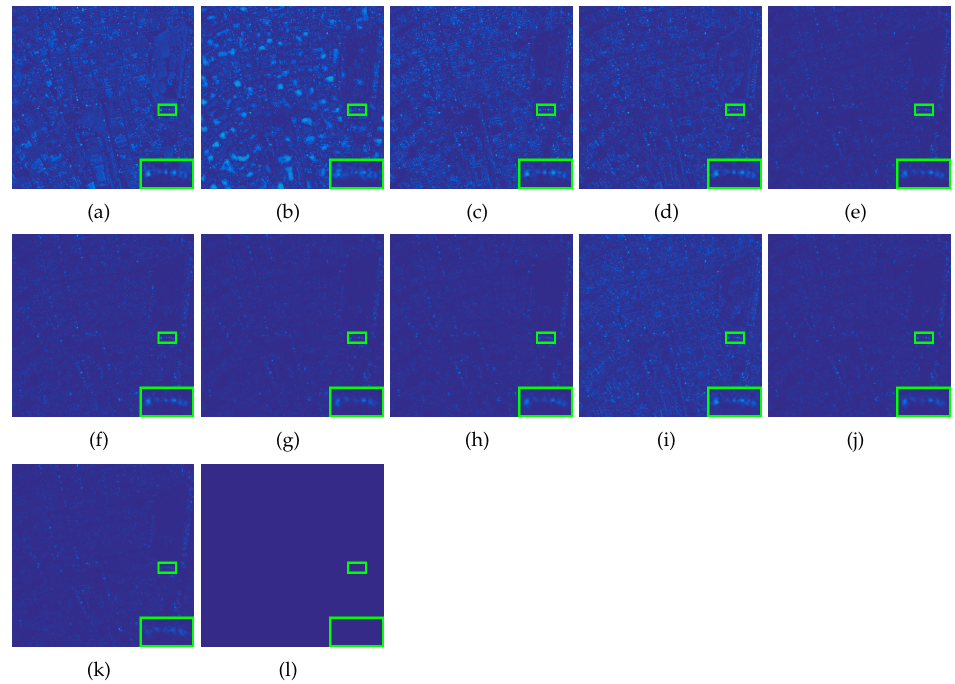
Figure 10. The residual images between the pansharpened results and reference images in Figure